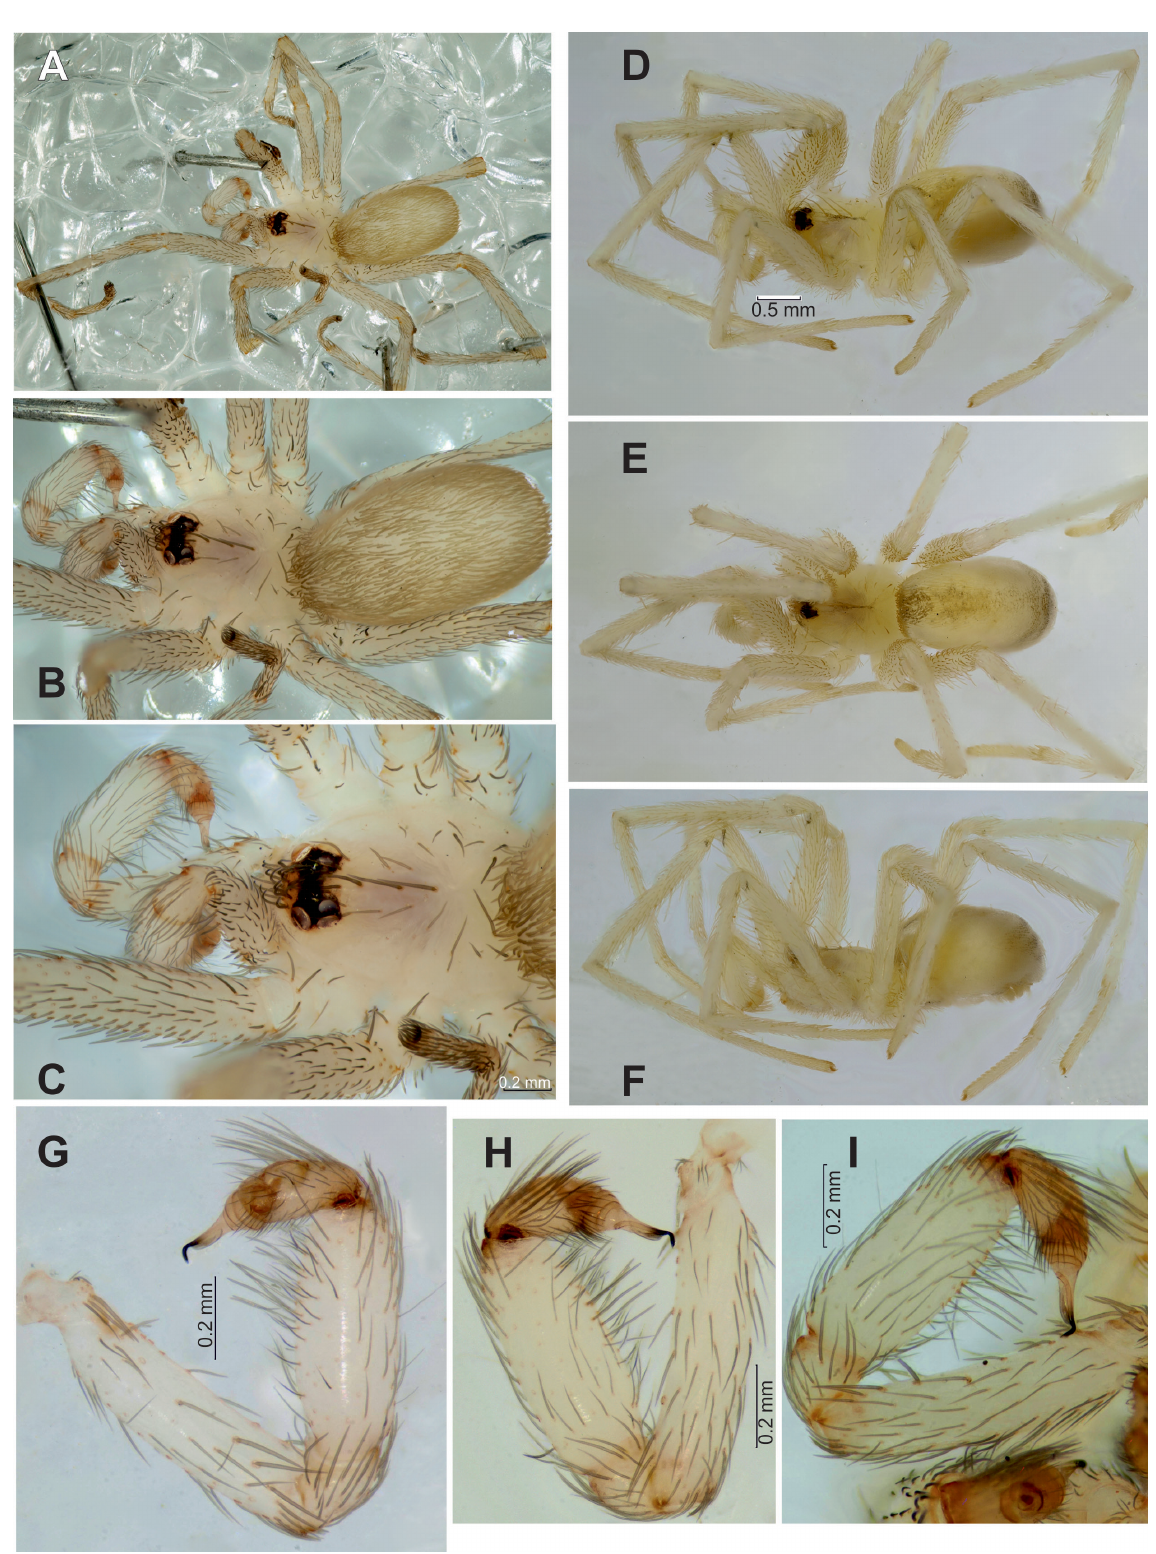
Fig. 28. Somatic characters and palp of Zaitunia beshkentica (Andreeva & Tyshchenko, 1969), ♂♂ from khurshedi ( A – C , G – I ) and Babatagh ( D – F ). — A , E . Habitus, dorsal. B . Body, dorsal. C . Prosoma, dorsal. D , F . Habitus, doro-lateral and lateral. G . Palp, retrolateral. H–I . Same,